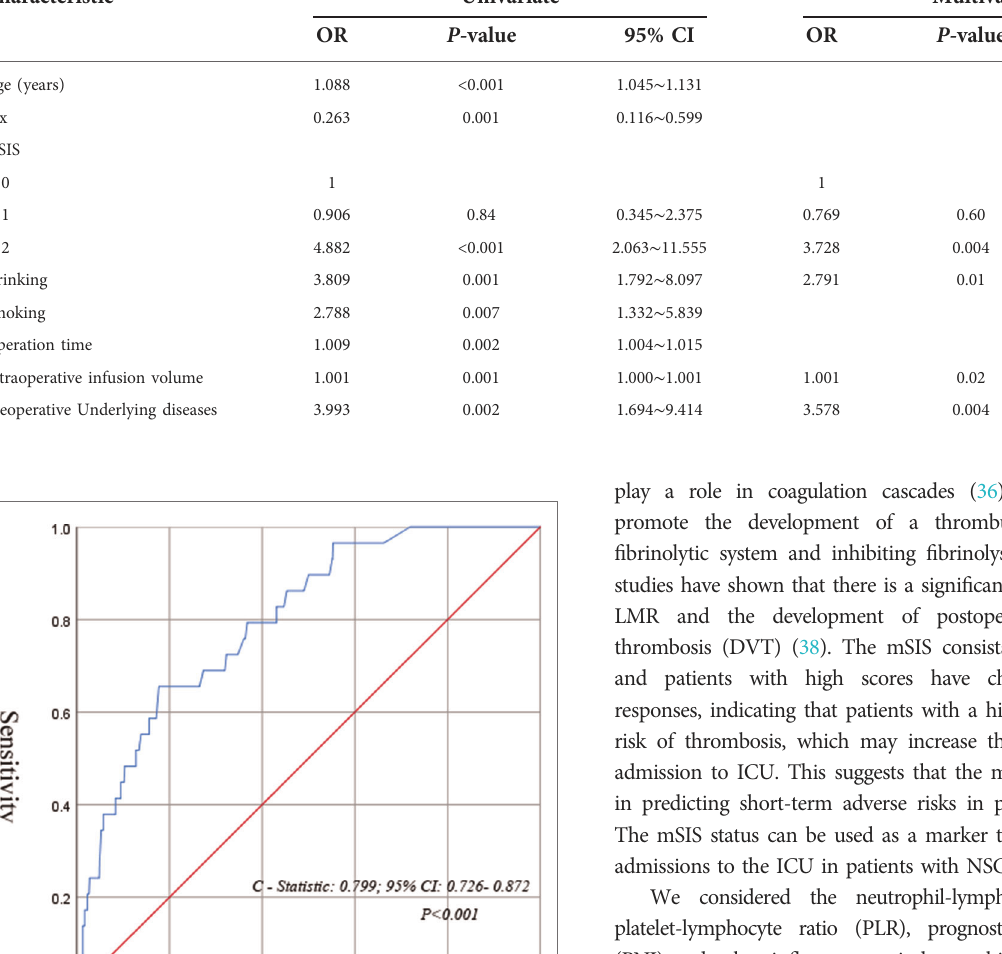
TABLE 4 Univariate and multivariable analysis of patients with unplanned ICU admission.